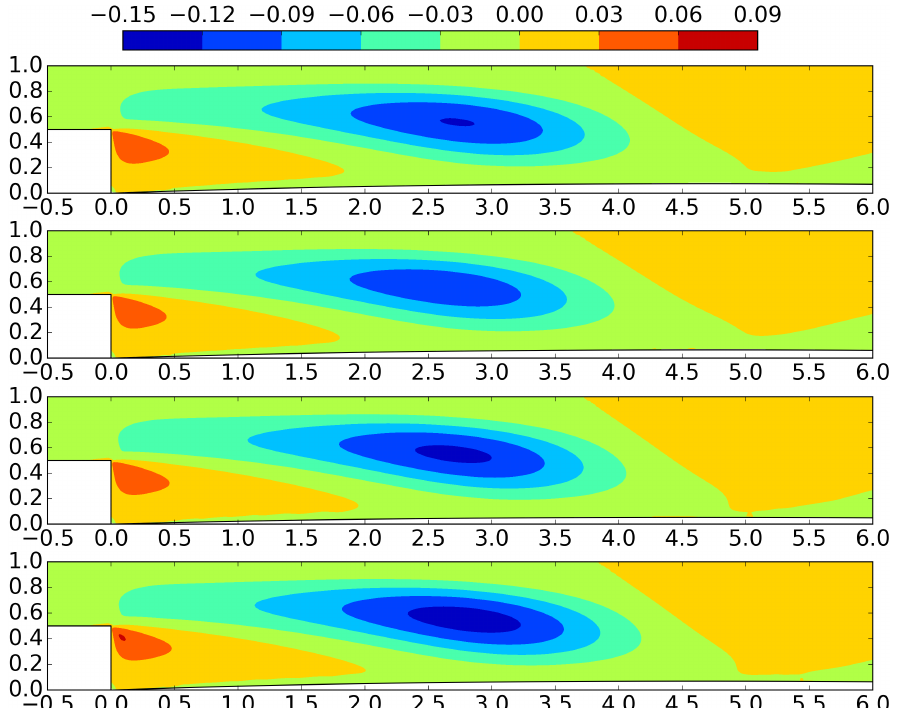
Figure 19. Transverse velocity contours for t = 0, t = T /4, t = T /2, t = 3 T /4, respectively, during a period T , for FSI of the flow with a membrane with T m = 55 and p e = 0.55. The inflow (Equation (1)) is oscillating with α = 0.05 and ω = 0.05. The Reynolds number is